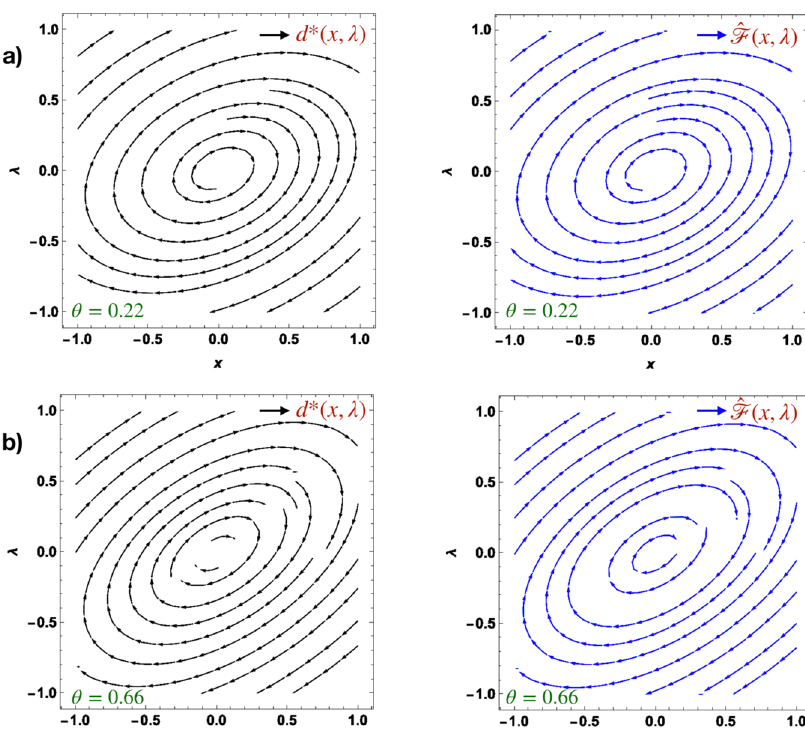
Fig. 3 The thermodynamic force fi elds obtained from the inference scheme. Thermodynamic force fi eld obtained as the optimal fi eld d *( x , λ ) using Eq. (7) (shown in black) compared to ^ F ð x ; λ Þ (shown in blue) which is the thermodynamic force fi eld obtained using the stochastic force inference technique 19 , in two cases. The parameter choices used correspond to two for different values of θ = A / D [ a θ = 0.22, and b θ = 0.55], where A is the amplitude of the noise in the Ornstein – Uhlenbeck process de fi ned in Eq. (10) and D is the room temperature diffusion constant. We see that d *( x , λ ) agrees well with ^ F ð x ; λ Þ .